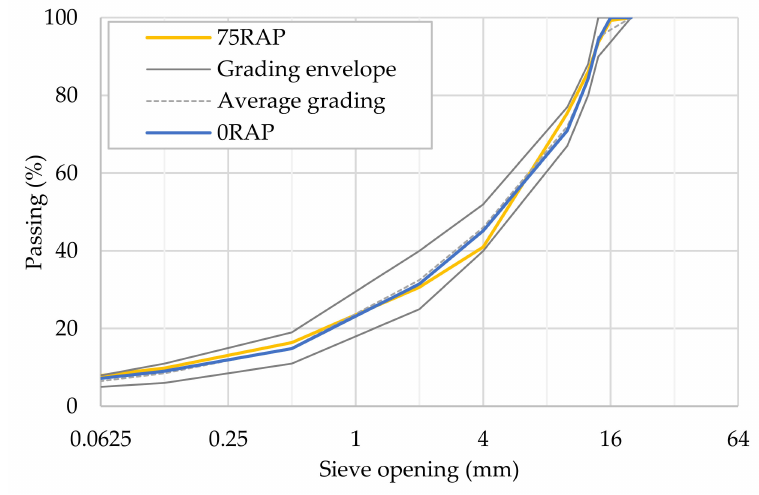
Figure 5. Aggregate grading